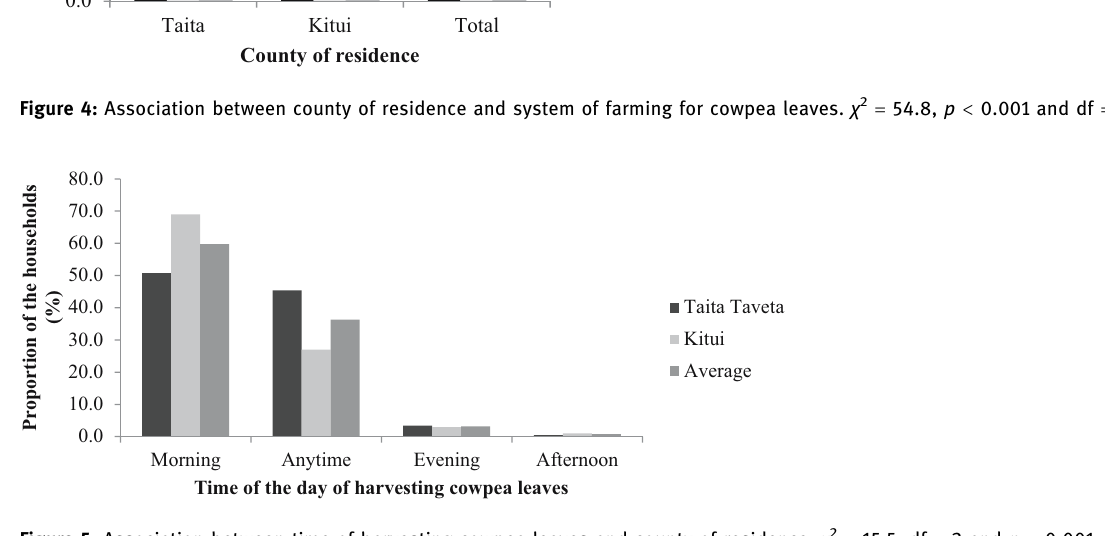
Figure 5: Association between time of harvesting cowpea leaves and county of residence. χ 2 = 15.5, df = 3 and p = 0.001. Table 3: Beta values for predictor factors of production quantity of cowpea leaves Constraints